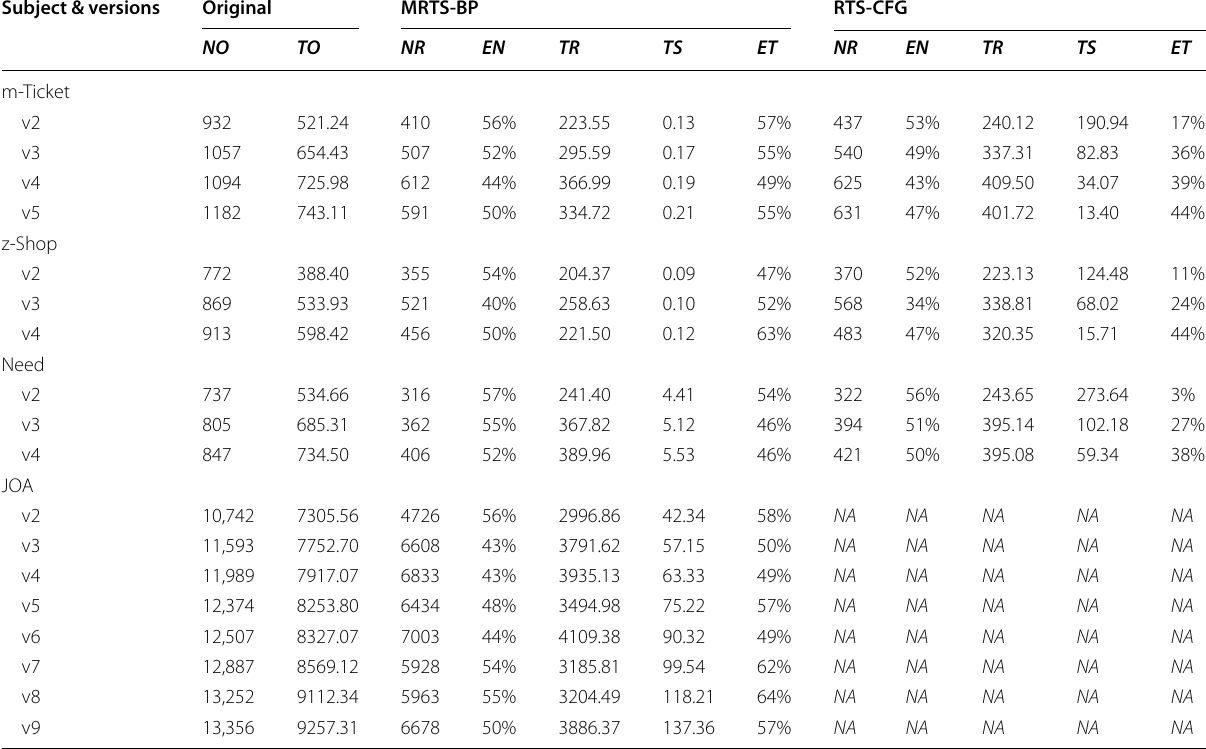
Table 4 Data of Experiment